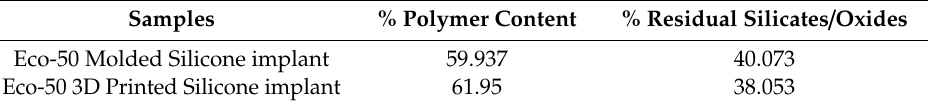
Table 3. Percentage (%) polymer content of material and % residual silicates / oxides.